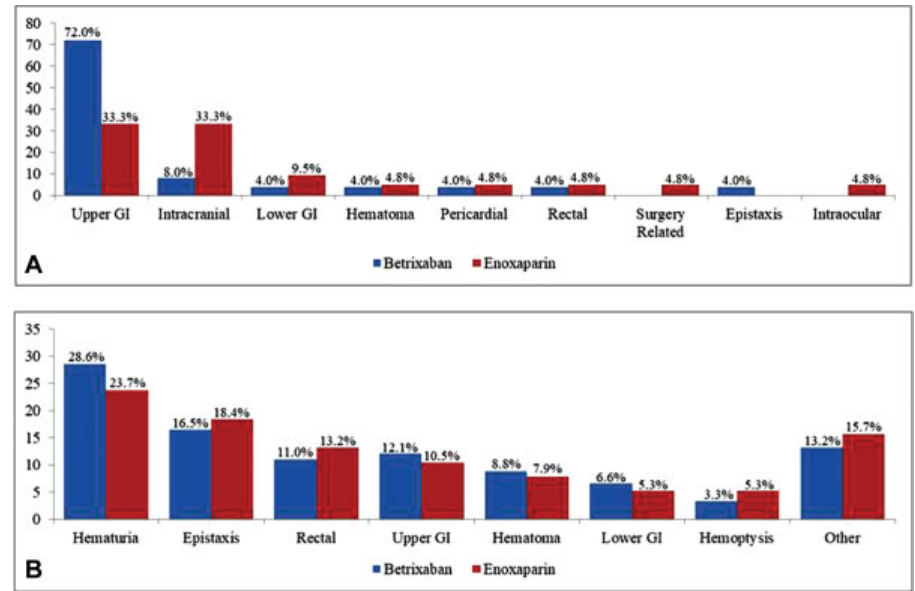
Fig. 1 Location of major bleeds ( A ) and location of CRNM bleeds ( B ). Other bleeds include laceration, hemothorax, vaginal (increased or prolonged menstrual or abnormal vaginal bleeding), bleeding associated with noncardiac surgery, gingival, puncture site, retroperitoneal, subconjunctival/ conjunctival, petechial rash/hemorrhage, baker ’ s cyst with intra cyst hemorrhage, and prevertebral space posterior hypopharynx